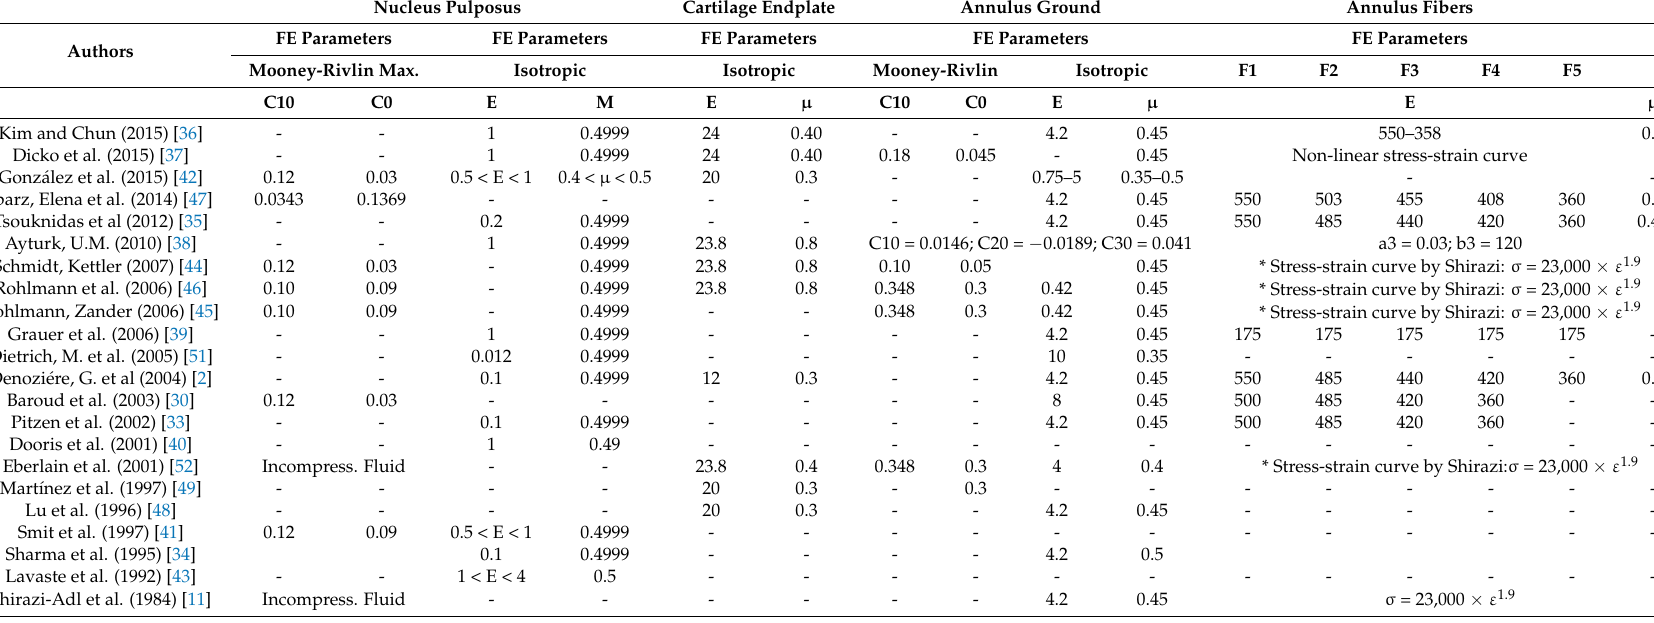
Table 1. Range of the material parameters proposed to define the behavior of human intervertebral lumbar disc models based on the finite element method